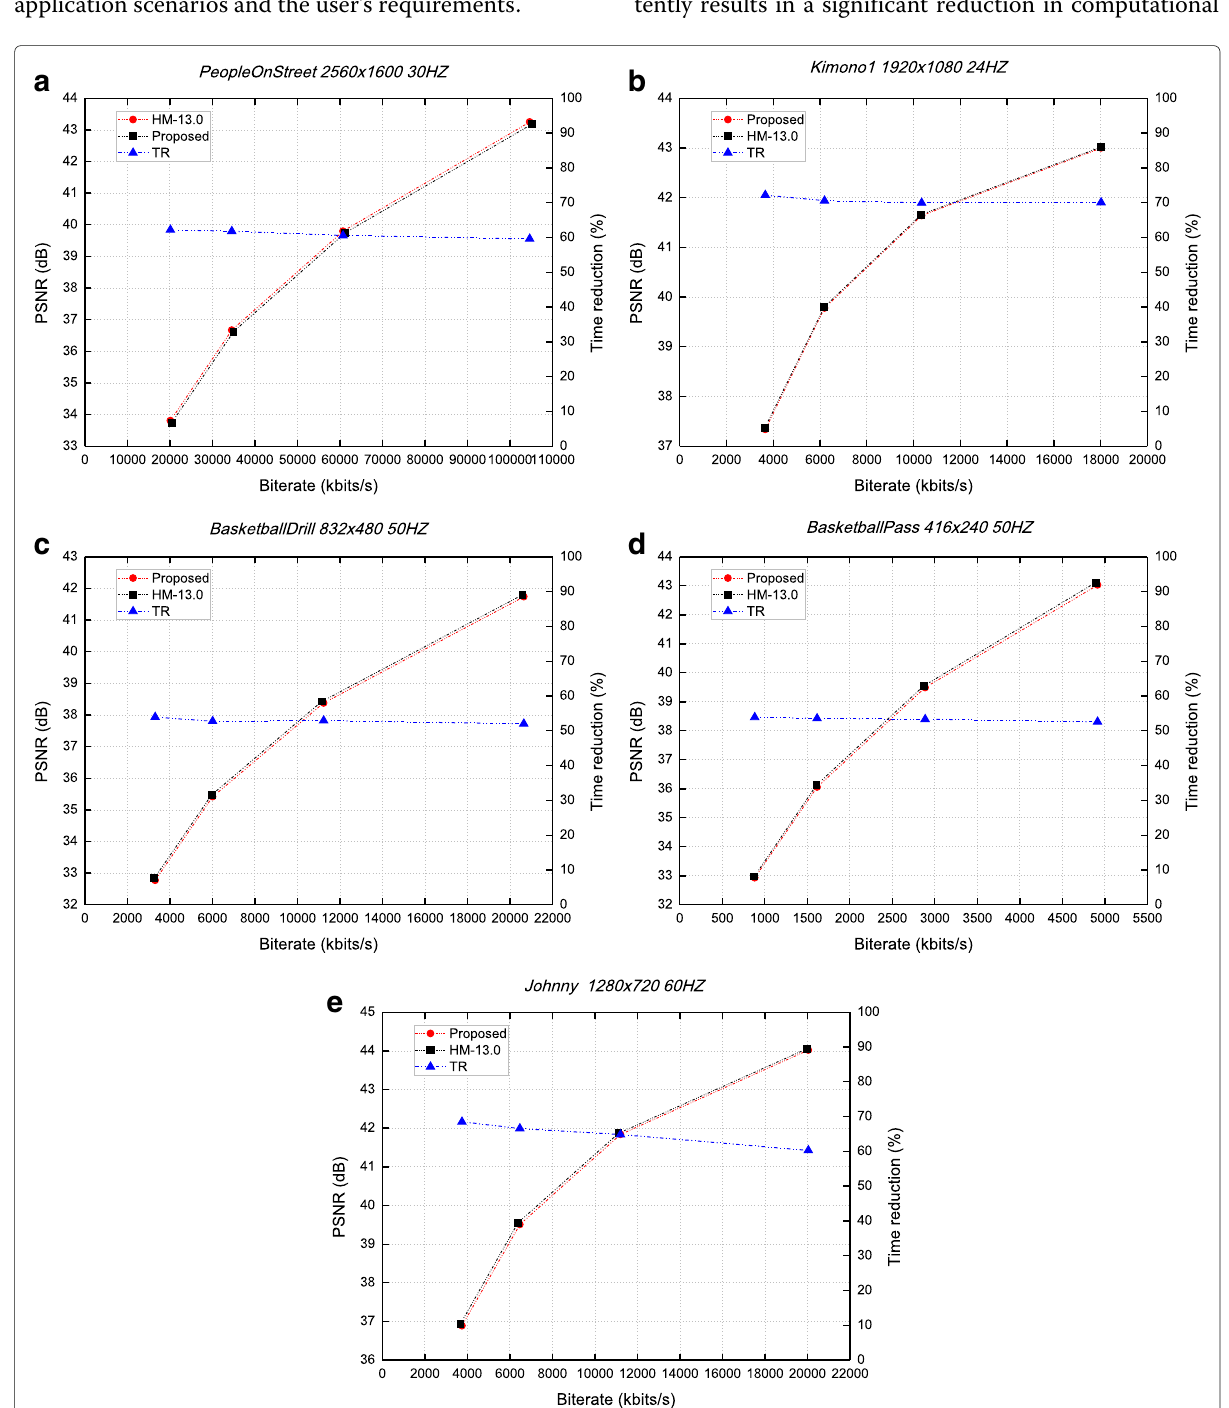
Fig. 9 Rate distortion and time saving curves for five video sequences at different solutions with QP values of 22, 27, 32 and 37. a PeopleOnStreet. b Kimono1. c BasketballDrill. d BasketballPass. e